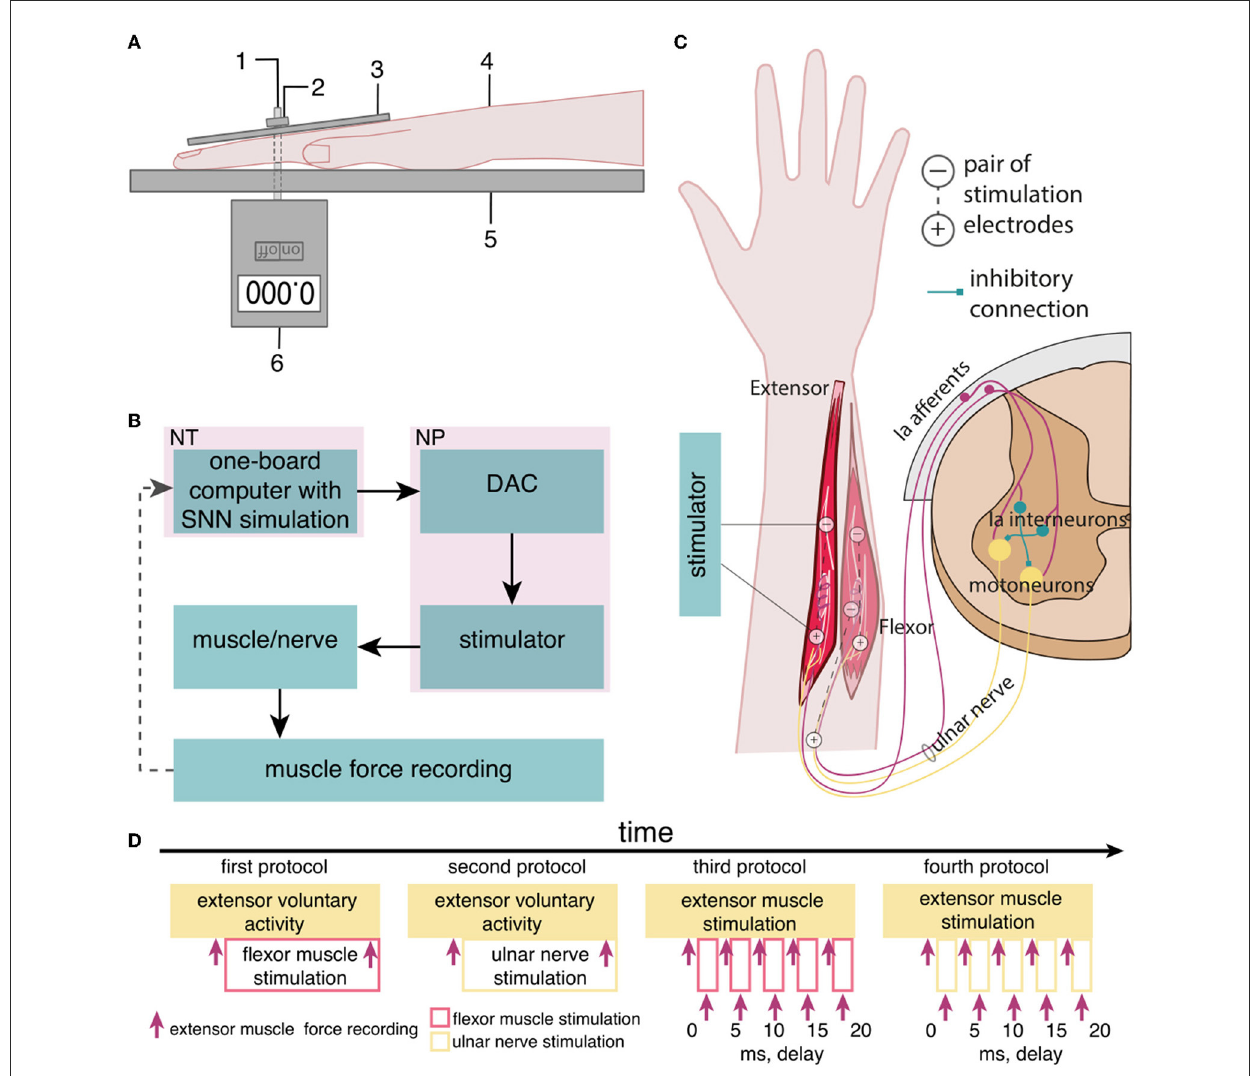
FIGURE1 The setup of the neurointerface for muscle stimulation and muscle force recording. (A) (1) Fasteners, (2) the clamp, (3) the upper plate, (4) the volunteer’s hand, (5) the lower plate, and (6) the dynamometer; (B) the setup of the neurointerface where NT is the neuroterminal and NP is the neuroport; and (C) the diagram of stimulation: (1) activated muscles and nerve, (2) placement of electrodes [the antagonist muscle (flexor) inhibits the extensor via reflex arc]; and (D) the timeline of the